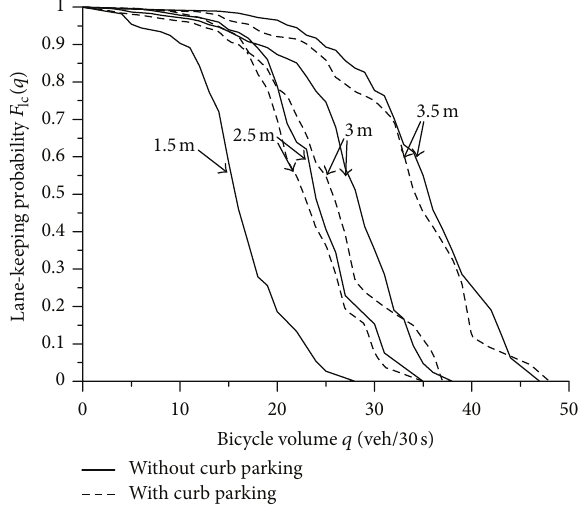
Figure 3: Distributions of lane-keeping probability under infleucne of curb parking.